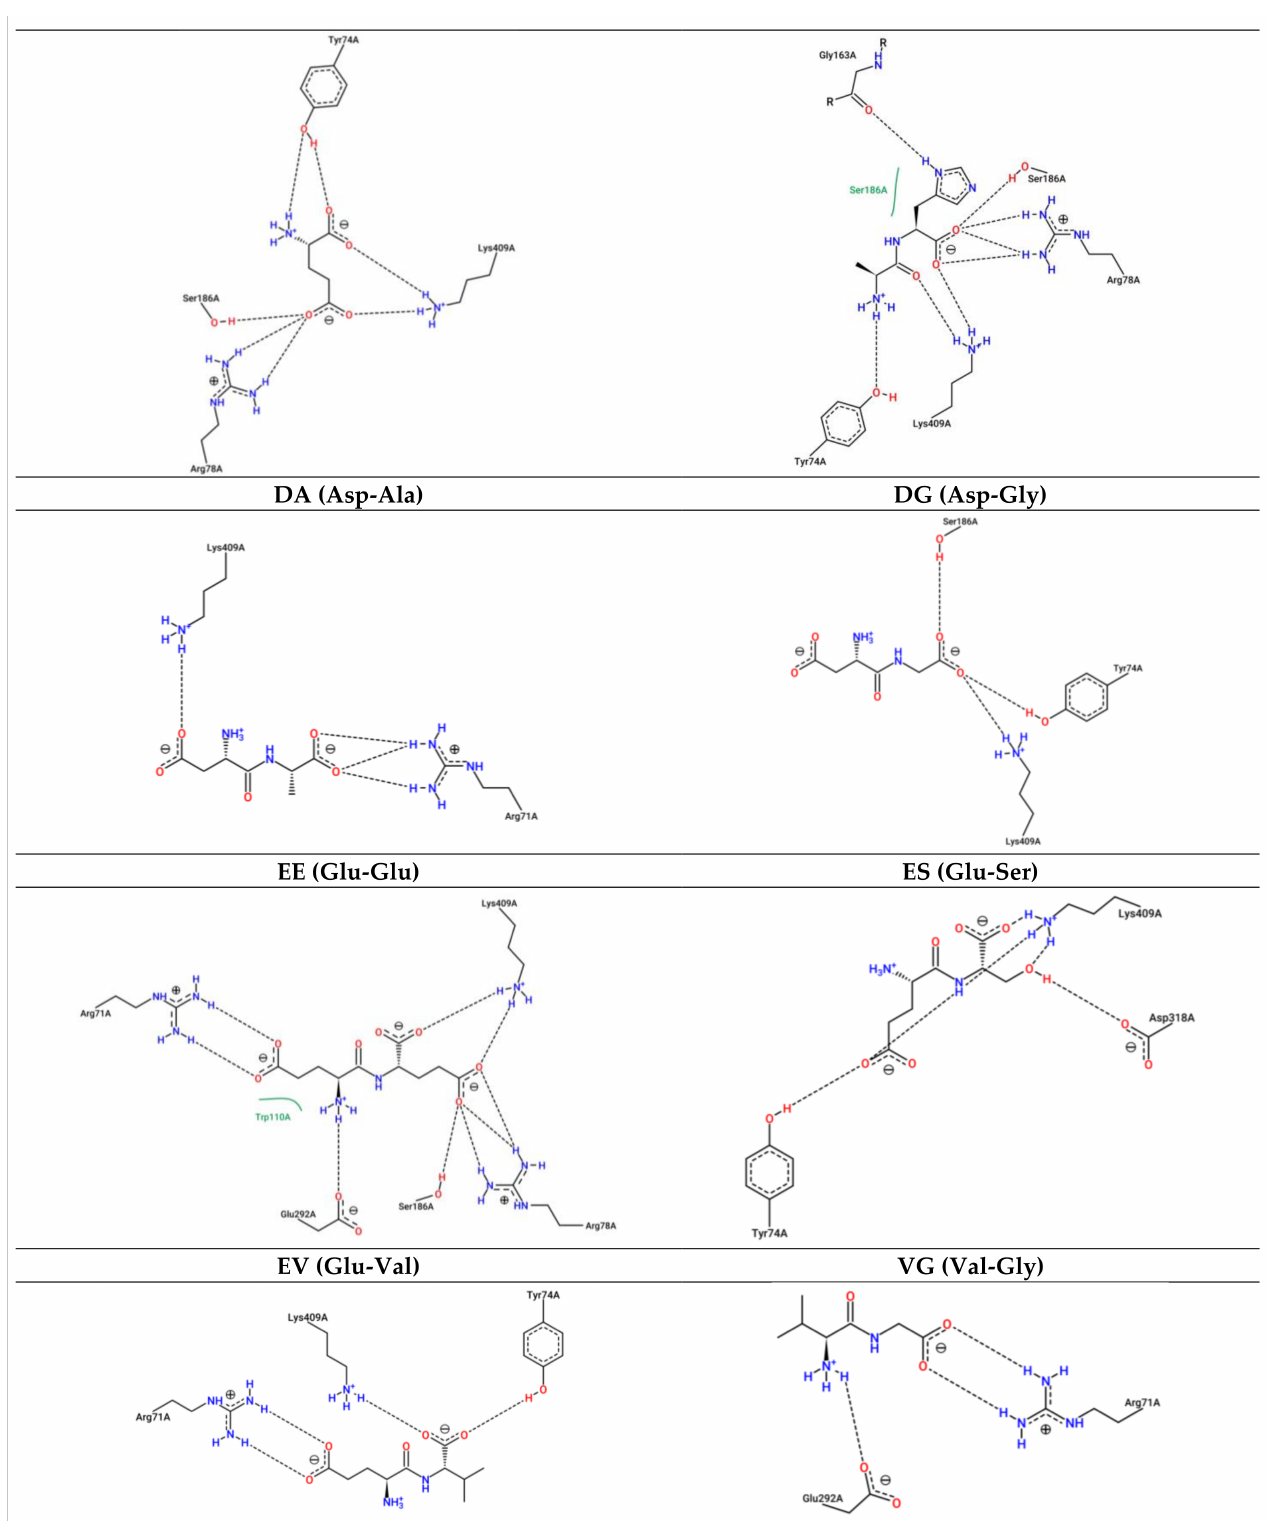
Figure 3. Two-dimensional representation of protein–ligand interactions between Rattus norvegicus open–open conformation of mGluR1 (PDB ID: 1EWT) and Glu (PubChem ID: 33032), AH (PubChem ID: 9837455), DA (PubChem ID: 5491963), DG (PubChem ID: 151148), EE (PubChem ID: 439500), ES (PubChem ID: 6995653), EV (PubChem ID: 6992567), VG (PubChem ID: 6993111). H bonds are shown as dashed lines, hydrophobic contacts are represented by green splines; the corresponding pocket residues are also shown in the same color. Diagrams obtained from the ProteinsPlus PoseView tool, from which